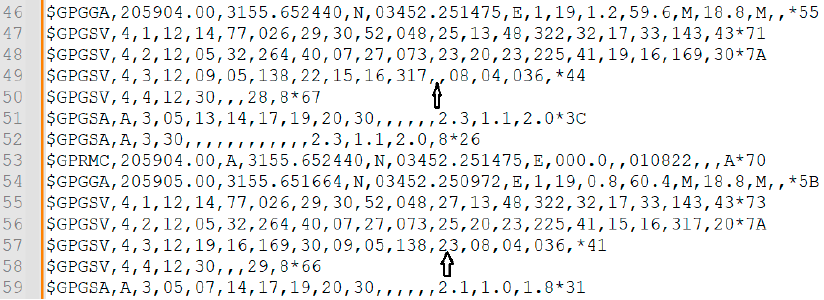
Figure A5. Different fields in the same type of line.